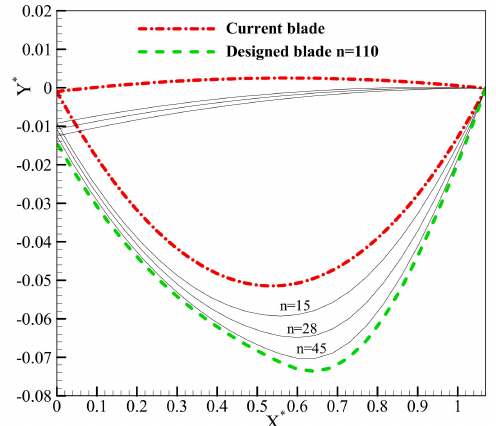
Figure 22. Geometry correction process for the third design case by UESA (n defines the number of iteration steps; non-dimensionalized coordinates of X* and